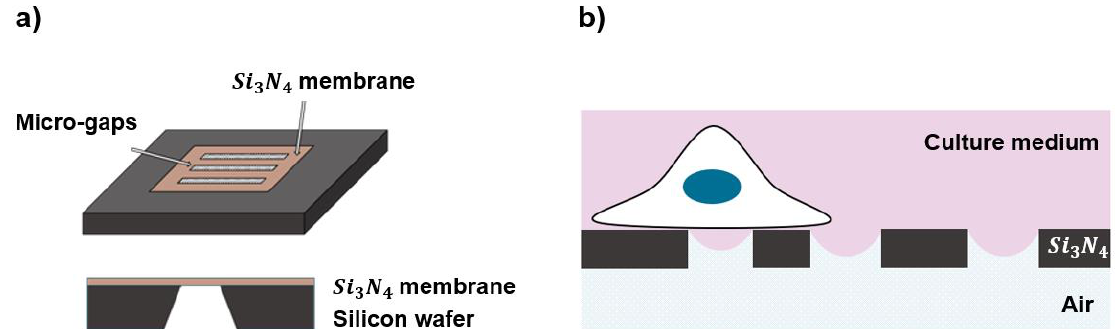
Figure 1. ( a ) Top and side view of the chip with substrate, where the micro-patterned structures were created in the SiN membrane; ( b ) a schematic representation of half-wet configuration experienced by a cell grown on the top of the patterned substrates, where the culture medium is covered on the “cell side” and the substrates are exposed to air on the other side or “air side”.